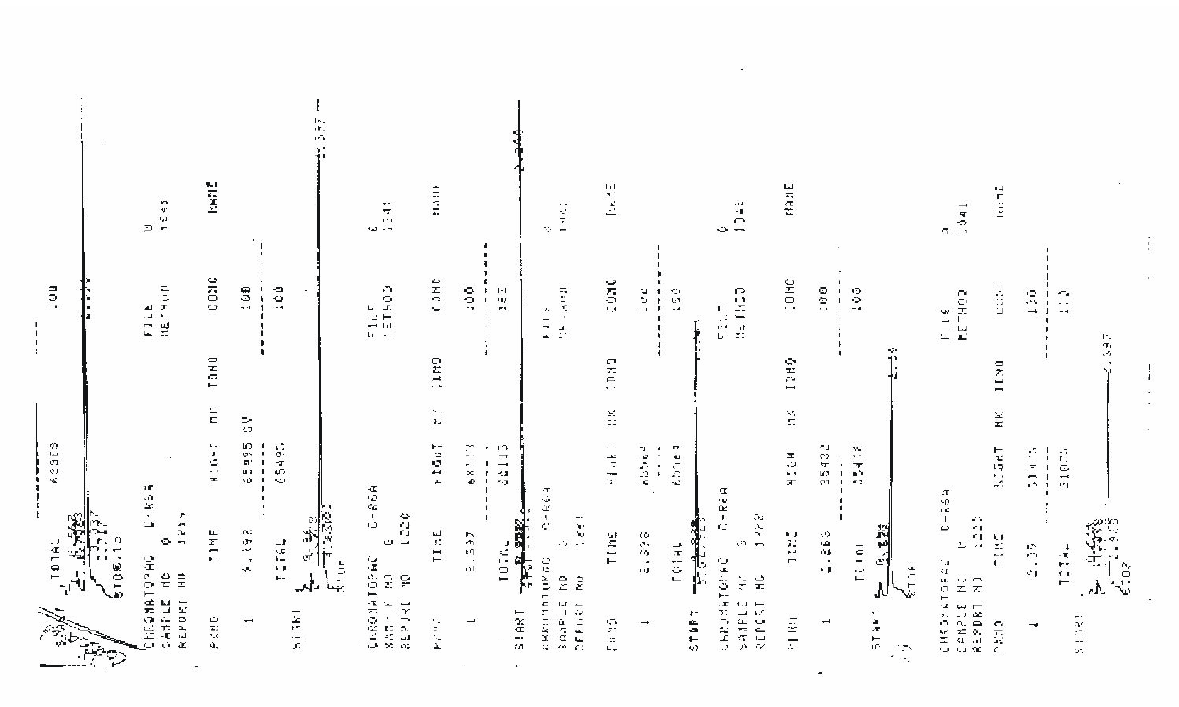
Fig (1 a )H.P.L.C for a mixture of equal quantities of the compound (BA 1 ) and the standard